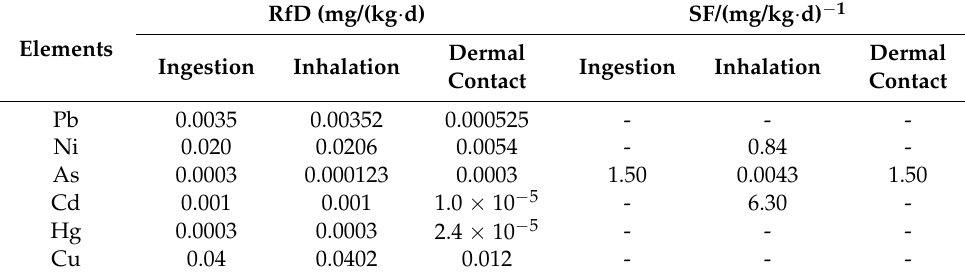
Table 2. Reference dose and slope factor for three exposure pathways of heavy